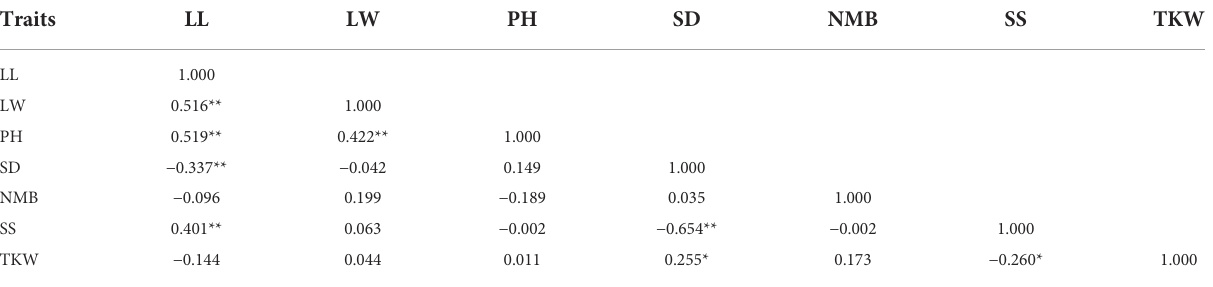
TABLE 3 Correlation analysis between seed shattering and other seed shattering-related traits.